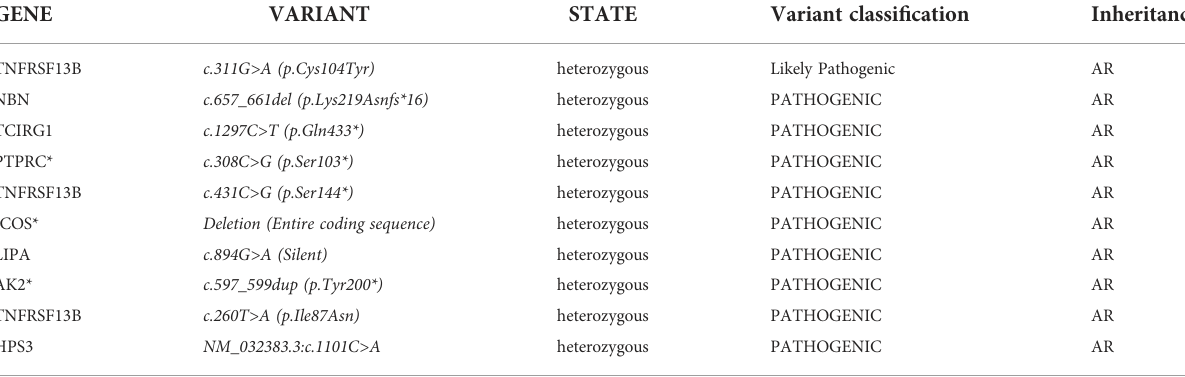
TABLE 2 List of pathogenic variants responsible for AR PIDs in patients tested with NGS technology in heterozygous stage. GENE